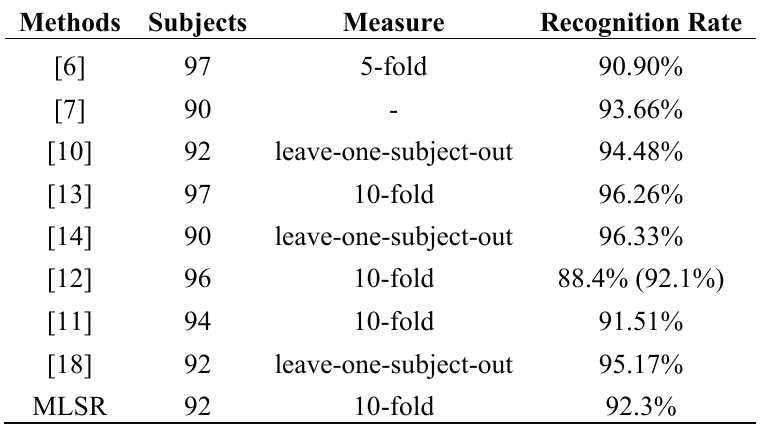
Table 4. Comparison with state-of-the-art performance of the proposed algorithm on the CK